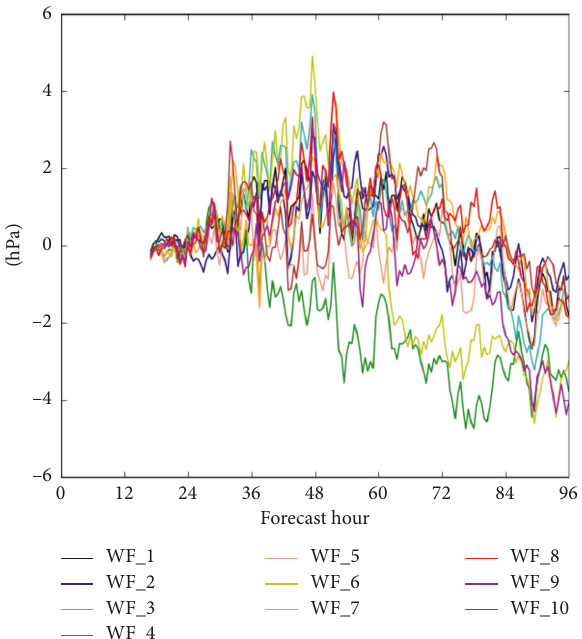
Figure 2: Example time series of cyclone minimum sea-level pressure perturbation from the control run. The case shown here represents the tropical cyclone case initialized on 24 August 2011